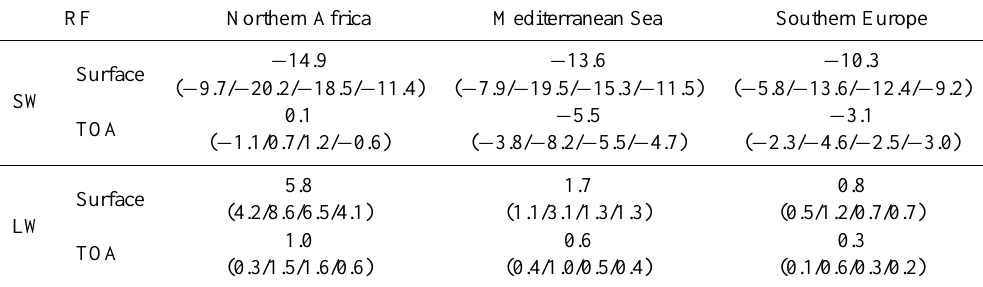
Table 3. Annual (first line of each cell) SW and LW direct radiative forcing averages (Wm − 2 ) at the surface and TOA for the NEW simulation over Northern Africa (from 25 ◦ N to the sea), the Mediterranean Sea and Southern Europe (from the sea to 47.5 ◦ N). Seasonal averages (DJF/MAM/JJA/SON) are indicated on the second line of each cell for the same regions and parameters.